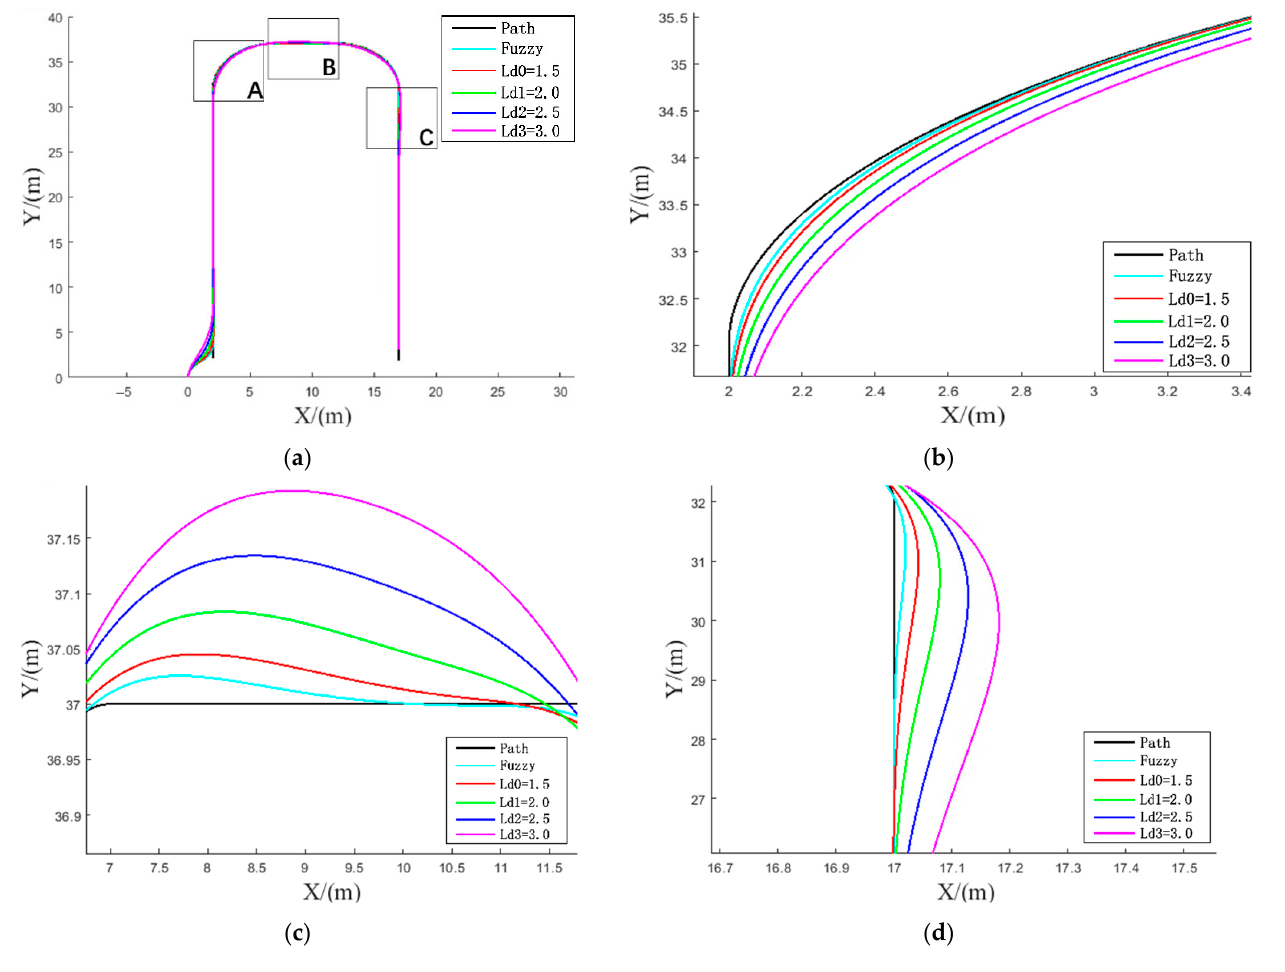
Figure 13. Pure tracking algorithm of fuzzy control. ( a ) Bow turn path tracking; ( b ) Partial enlarge- ment at A; ( c ) Partial enlargement at B; ( d ) Partial enlargement at C.